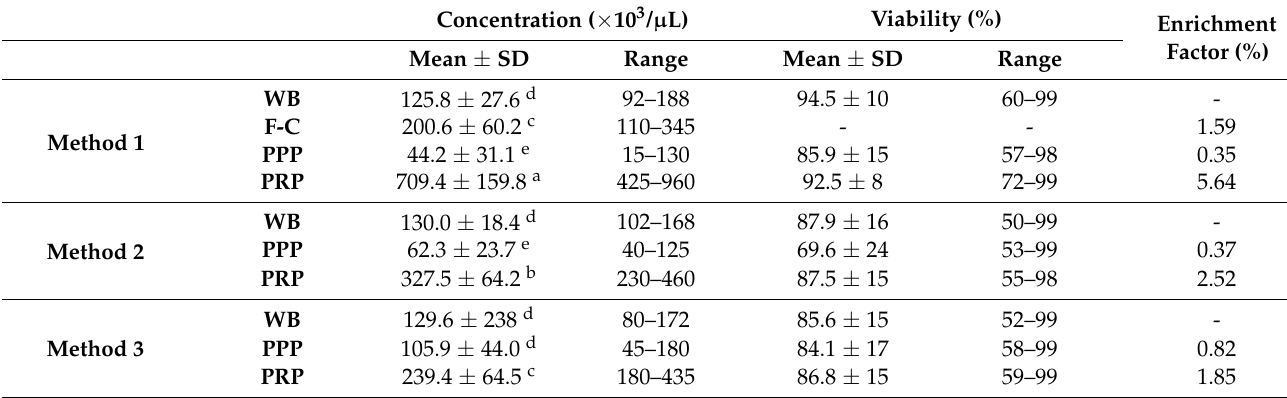
Clumps classification: score 0 , absence of platelet clumps; score 1 , small platelet clumps identified in the hemocytometer chamber, but not within the squares used to obtain the platelet count; score 2 , small platelet clumps (~2–5 platelets/clumps) occurring in low numbers throughout the chamber and within the squares used for counting; score 3 , presence of low numbers of larger platelet clumps (~5–20 platelets/clump), or high numbers of small platelet clumps; score 4 , presence of many large platelet clumps. Different